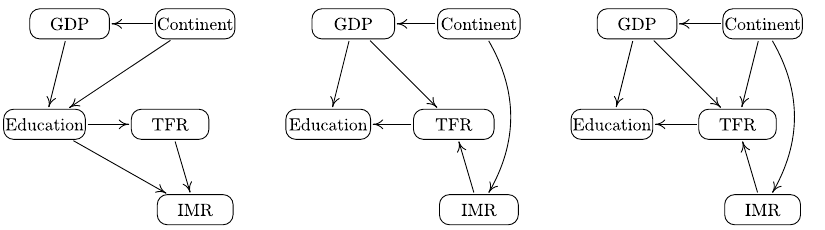
Figure 1: Three candidates for a causal DAG with target total fertility rate (TFR) and four potential causal predictor variables. We would like to infer the parents of TFR in the true causal graph. We use the continent as the environment variable E . If the true DAG was one of the two graphs on the left, the environmental variable would have no direct influence on the target variable TFR and ‘Continent’ would be a valid environmental variable, see Definition